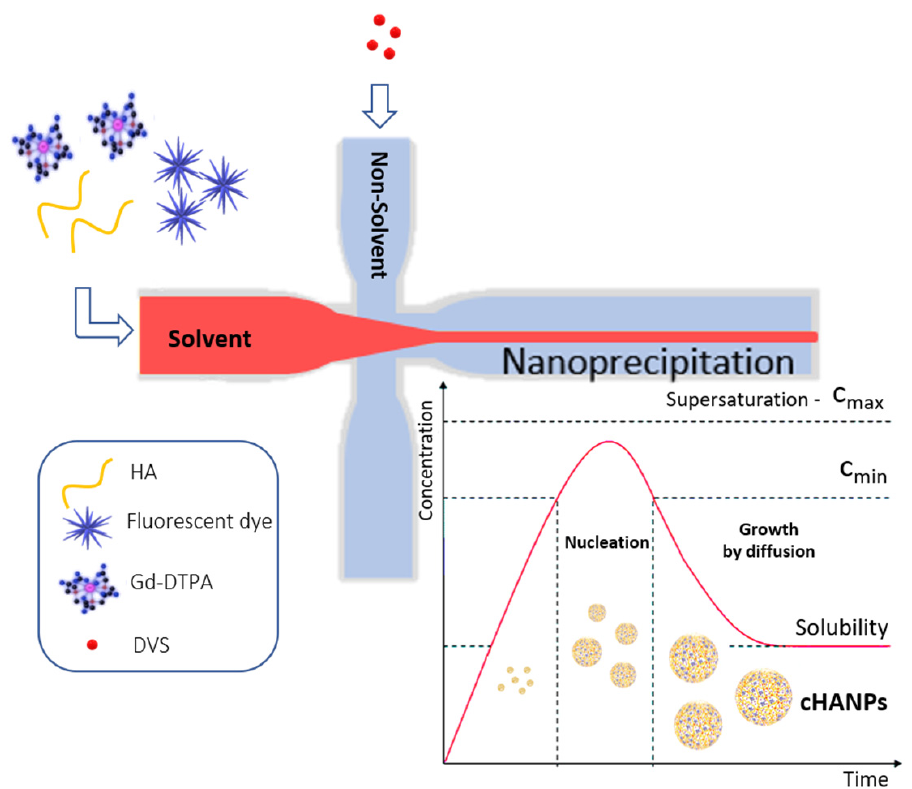
Figure 1. Schematic representation of the microfluidic set-up for crosslinked hyaluronic acid nanoparticles (cHANPs) production.